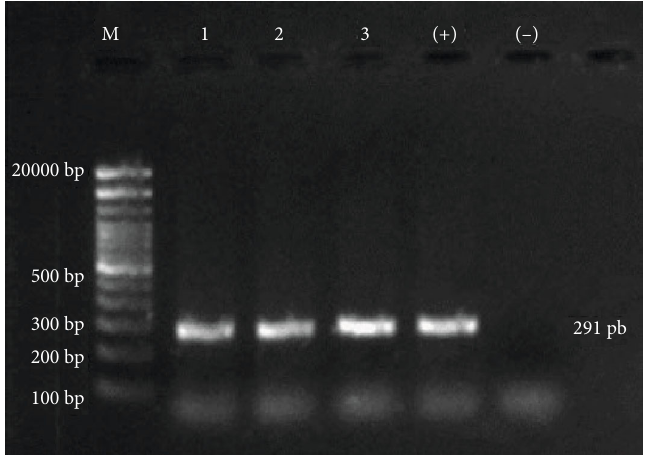
Figure 3: Detection of Maedi-Visna DNA from lung tissue of a sheep by PCR to determine the region of DNA repetition: lane M: 100pb DNA ladder; lanes 1-3: positive magni fi cation (291pb); lane (+): positive control; and lane (-): negative